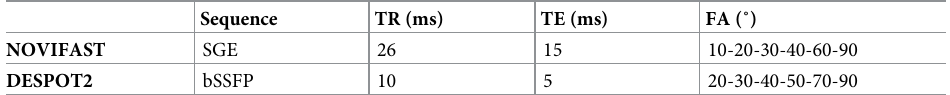
Table 1. Parameters of the NOVIFAST and DESPOT2 methods that were applied to obtain consecutively T 1 and T 2